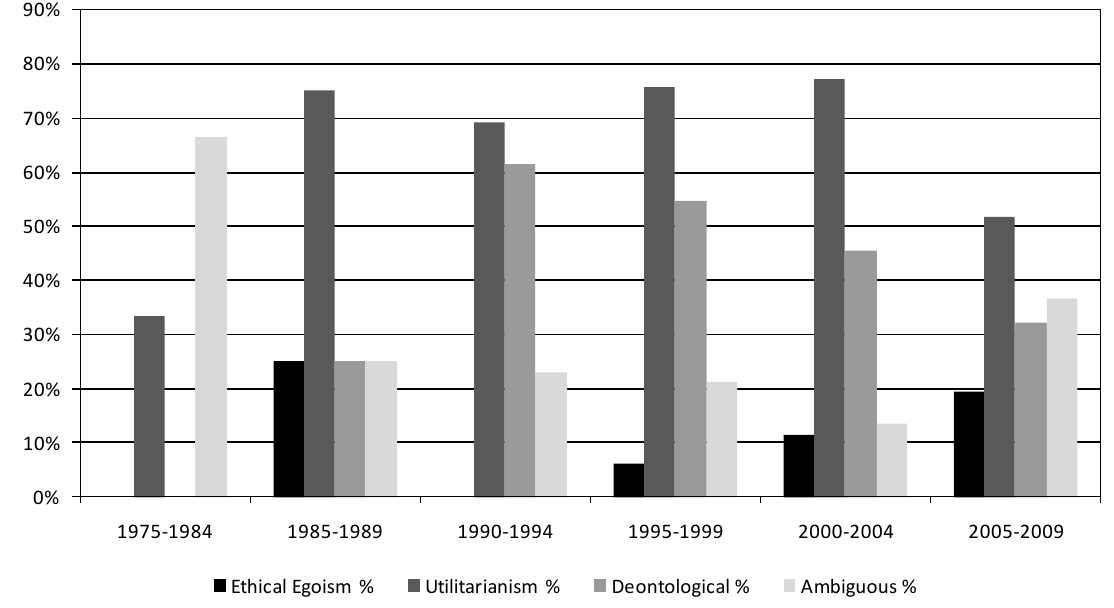
Figure 6: Ethical positions represented over